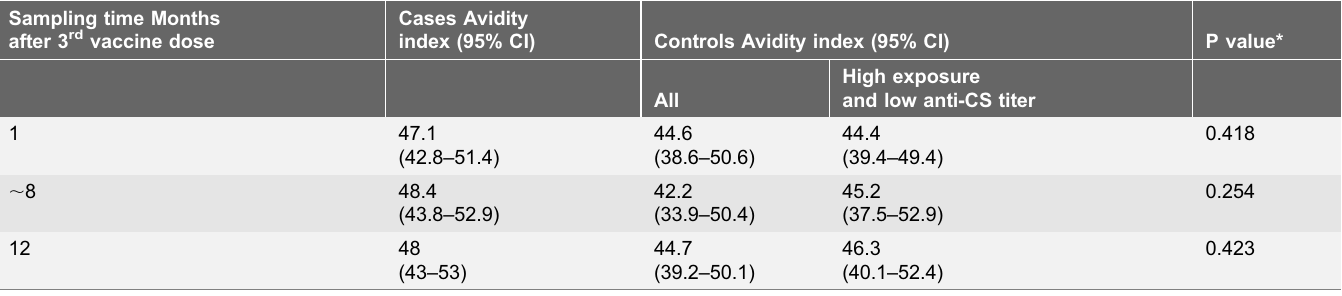
Table 1. Avidity indices in cases, controls and a subset of 19 controls with high exposure rates and low anti-CS titers at different sampling times. Sampling time Months after 3 rd vaccine